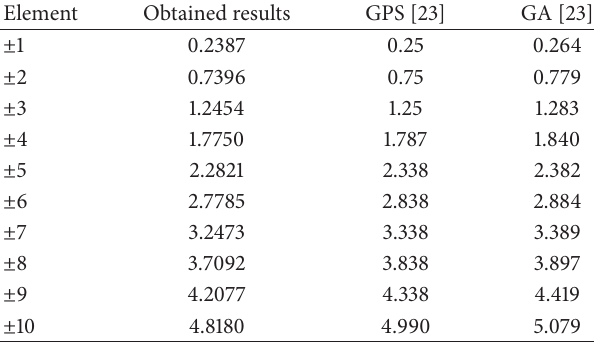
Table 4: Element position of the 20 element linear array (normal- ized with respect to 𝜆 ).